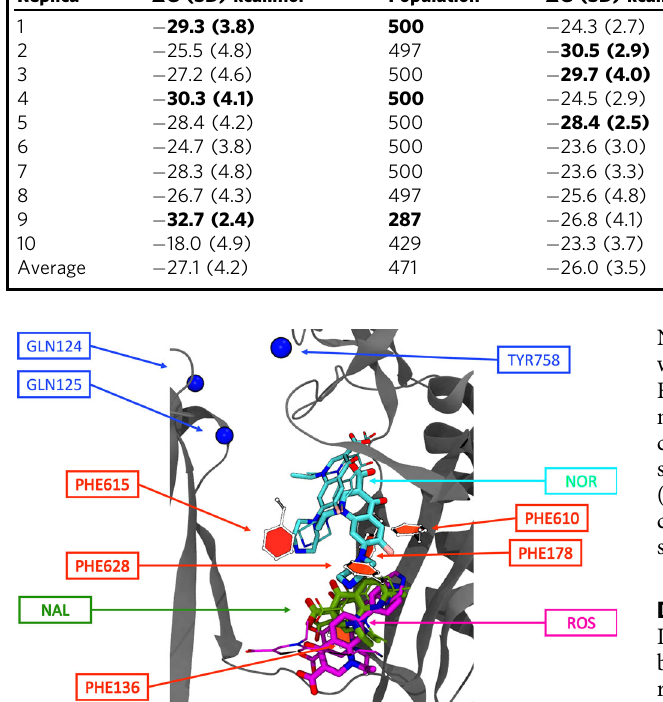
Fig. 7 Representative structures of the three most stable clusters of NAL, ROS and NOR within the DP T . The protein is shown in solid gray ribbons (only the PCX and PNX domains are shown for clarity); sidechains of the phenylalanines (PHE) lining the HT are shown using the CPK representation; residues lining the exit gate are highlighted as blue spheres. The NOR, ROS and NAL poses are shown as sticks with carbon atoms coloured cyan, magenta, and green, respectively. The thickest (thinnest) sticks indicate the pose with the lowest (highest) Δ G value,